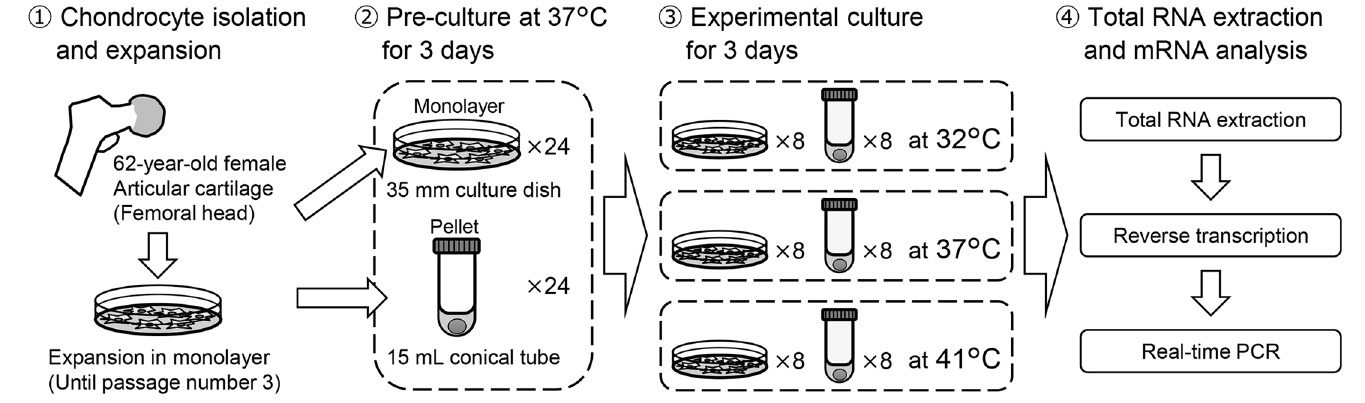
Fig 1. Experimental design.